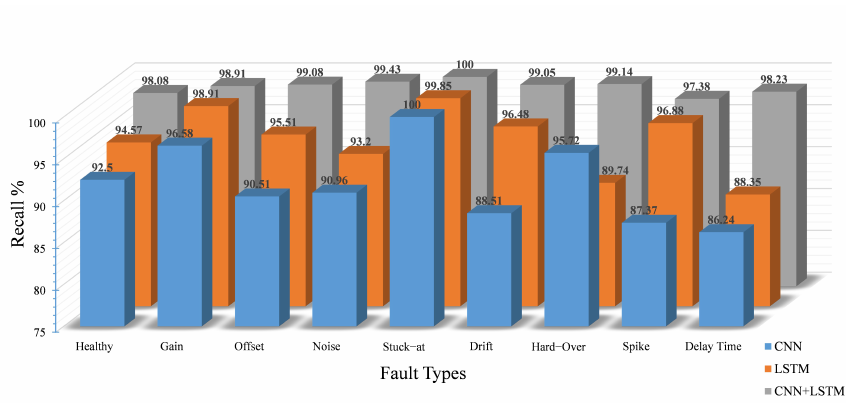
Figure 13. Classification performance in terms of